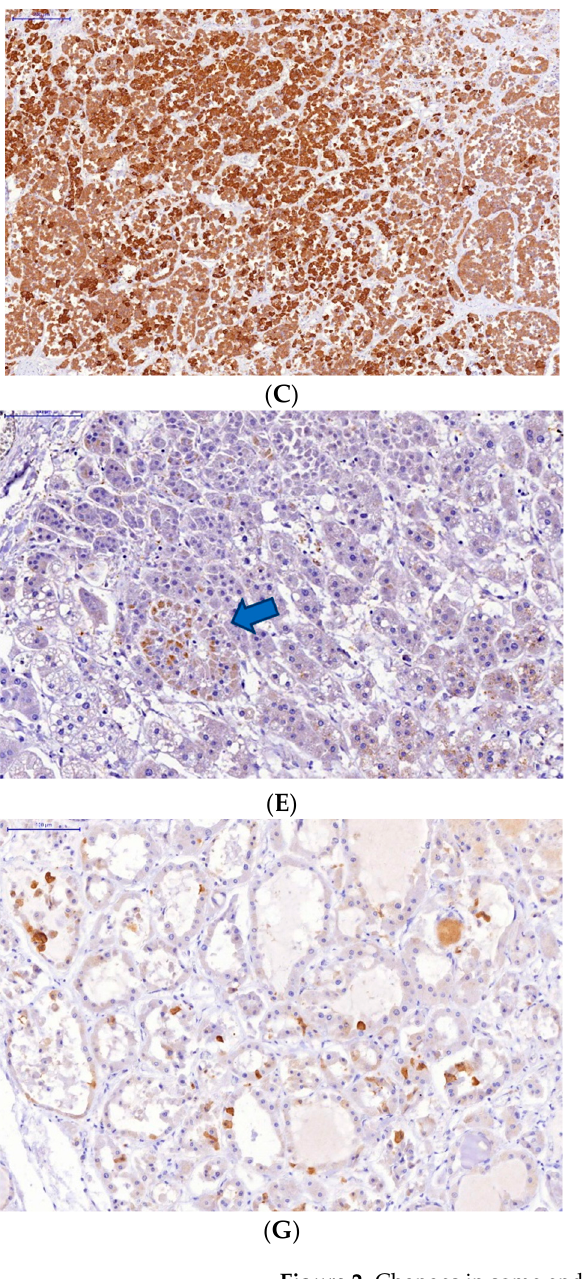
Figure 2. Changes in some endocrine organs of patients who died from COVID-19 infection. Uneven expression of SARS-CoV-2 spike antigen by pituitary cells ( A , B ): abundant expression by adenohy- pophysis cells ( C ) and no expression by neurohypophysis cells ( D ); focal expression of the SARS-Cov2 spike antigen by a group of degeneratively altered Caspasae3-negative adrenal parenchymal cells, arrows ( E , F ); expression of SARS-CoV-2 spike antigen by Caspasae3-negative thyroid follicle cells ( G , H ). ( A , C – E , G )—immunohistochemistry (IHH), rabbit polyclonal anti-SARS-CoV-2 Spike (GeneTex, USA), DAB; ( F , H )—IHH, mouse monoclonal anti-Caspasae3 (clone 3CSP03, Diagnostic BioSystems,